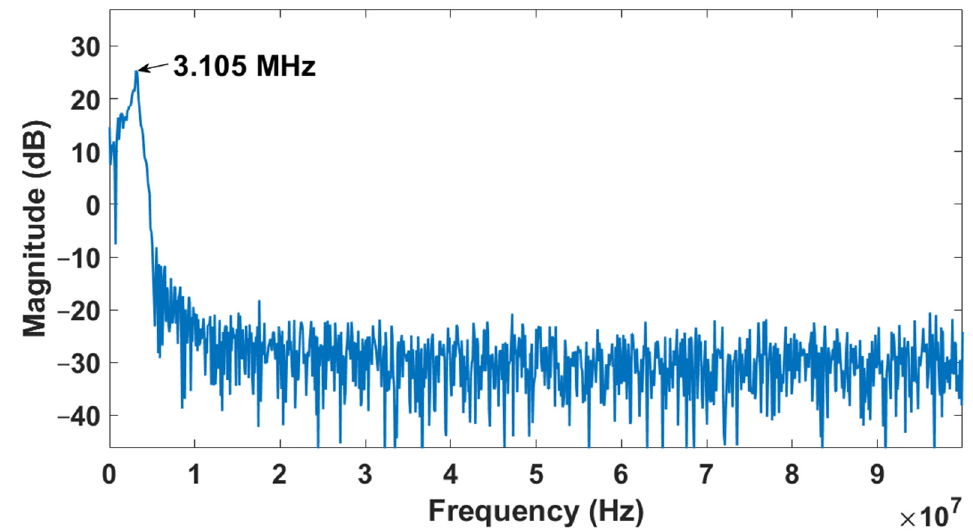
Figure 15. The resonance frequency of the CMUT immersed in fresh 5W20 engine